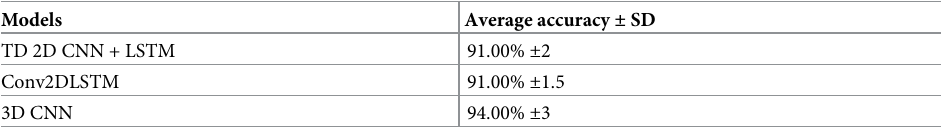
Table 1. This table presents the accuracy of the tests averaged over nine runs with LOOCV cross validation